Question: Provide a one-line summary of what is displayed.
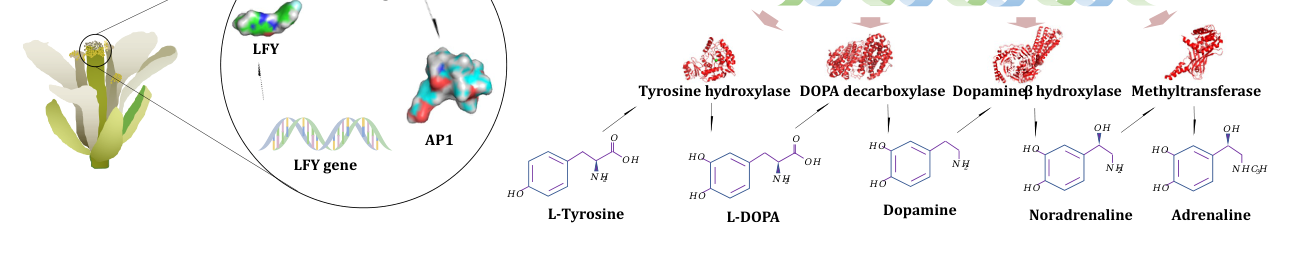
Answer: Interactions between genes. a. The expression product of the LEAFY (LFY) gene regulates APETALA1 (AP1) expression. b.The sequential process from tyrosine input to the final production of adrenaline.